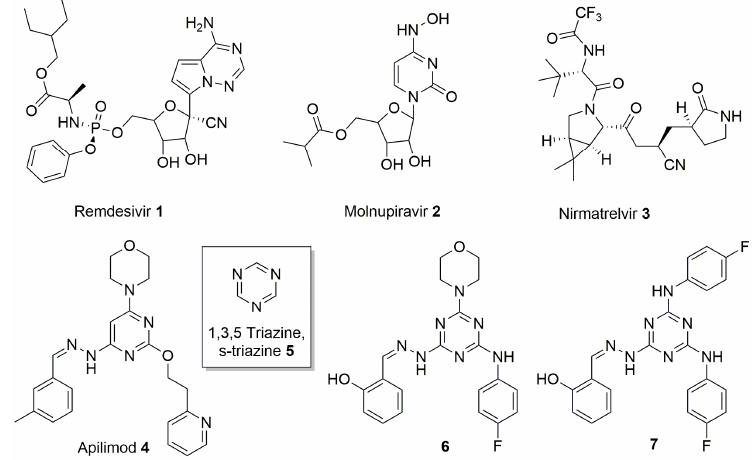
Figure 1. Chemical structures of Remdesivir 1 , Molnupiravir 2, Nirmatrelvir 3 , Apilimod 4 , s-triazine 5, and two highly decorated triazines previously identified 6 and 7 .